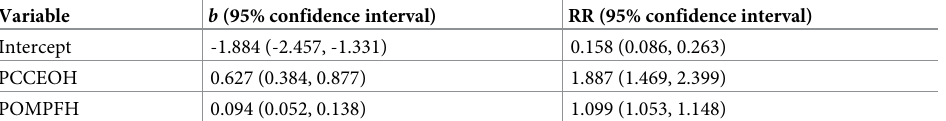
Table 2. The coefficients ( b ) and RR estimated by the multivariate Bayesian spatial model with two socioeconomic variables.